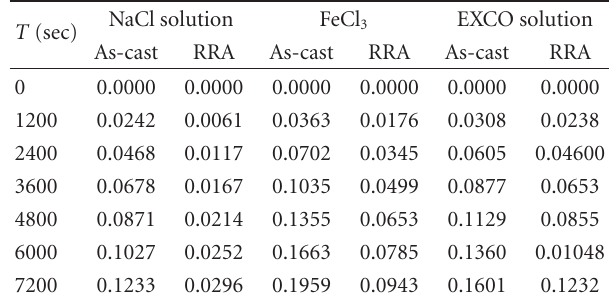
Table 10: Electrochemical corrosion rate for the 0.91% Mg specimen.